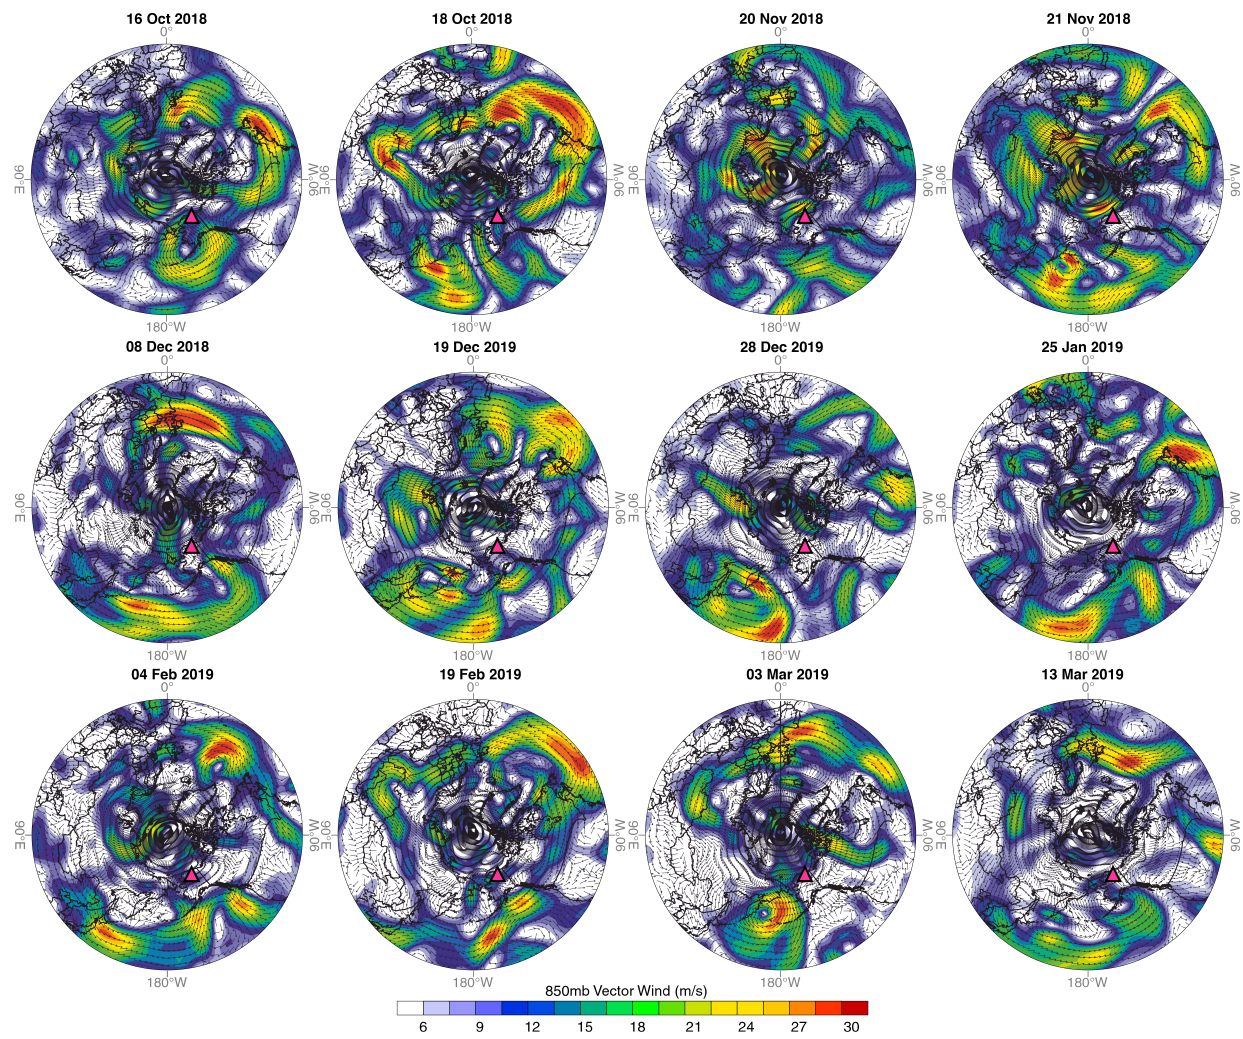
Figure A3. Northern Hemisphere (35 to 90 ◦ N) daily mean 850 mb vector winds during snowfall events sampled at Imnavait (triangle) in winter 2018–2019, from National Centers for Environmental Prediction (NCEP) and the National Center for Atmospheric Research (NCAR) NCEP/NCAR reanalysis